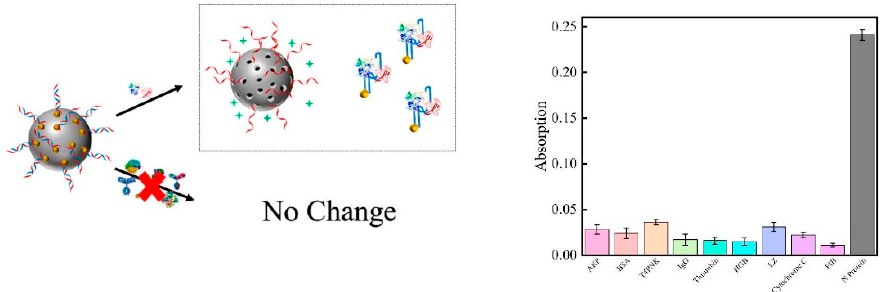
Figure 4. Selectivity of N protein aptamer toward target. From left to right, the 10 proteins are AKP